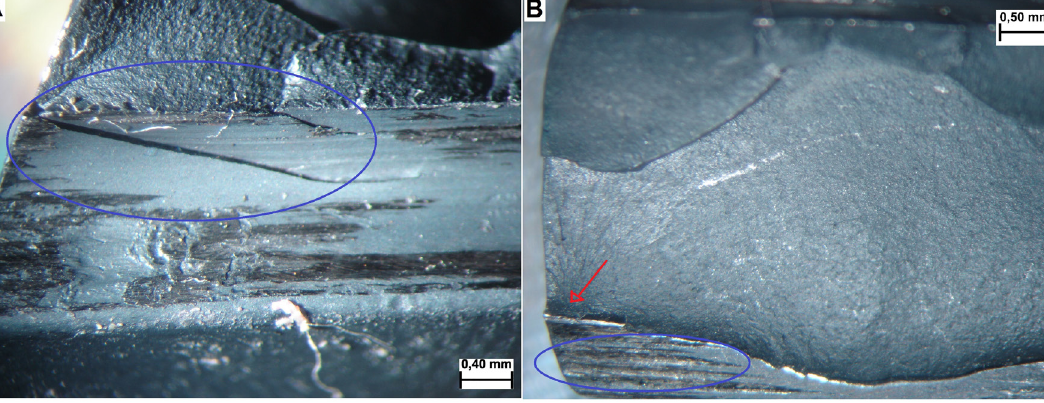
Figure 8. Stereographic images of the fracture surface of the P2 blade. (A) Detail with higher magnification of the region shown in Figure 7 . (B) Detail of the principal plane (plane 1) of fatigue crack